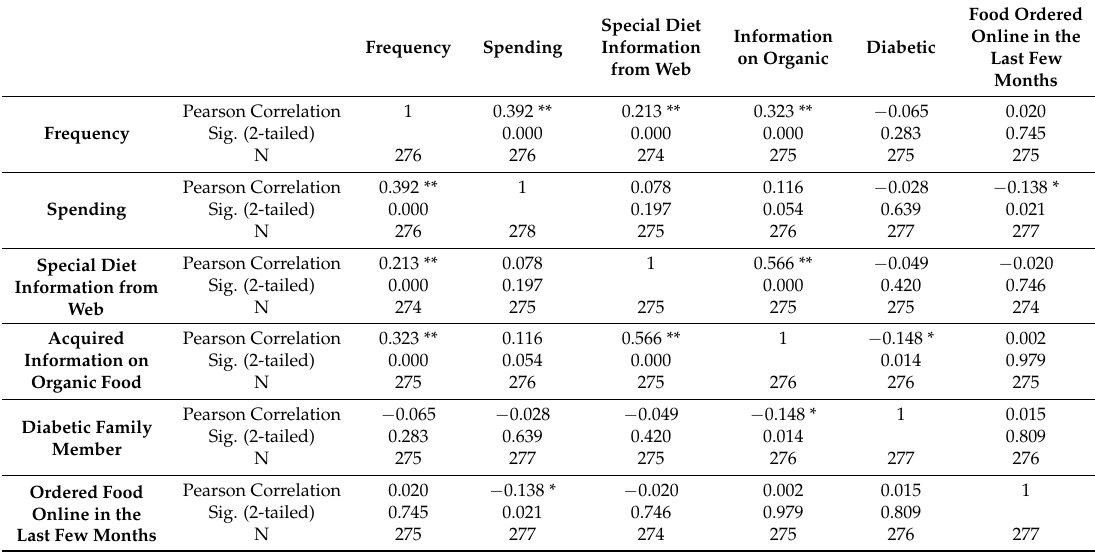
Table 2. Correlation between frequency of purchasing food online and consumer special requests.